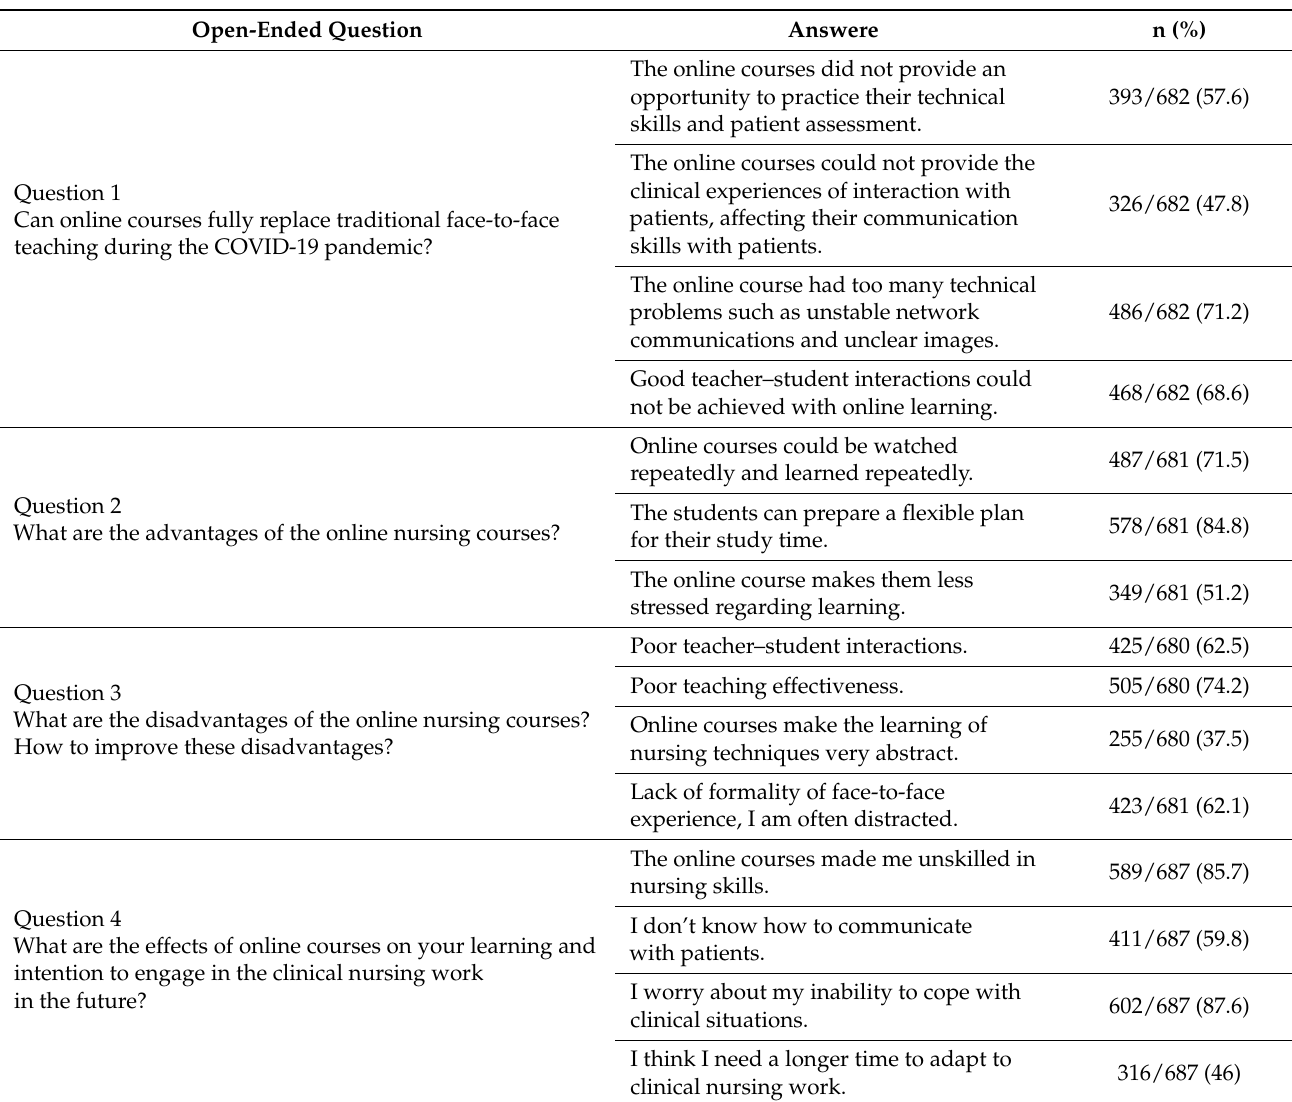
Table 7. Analysis of the responses to the open-ended